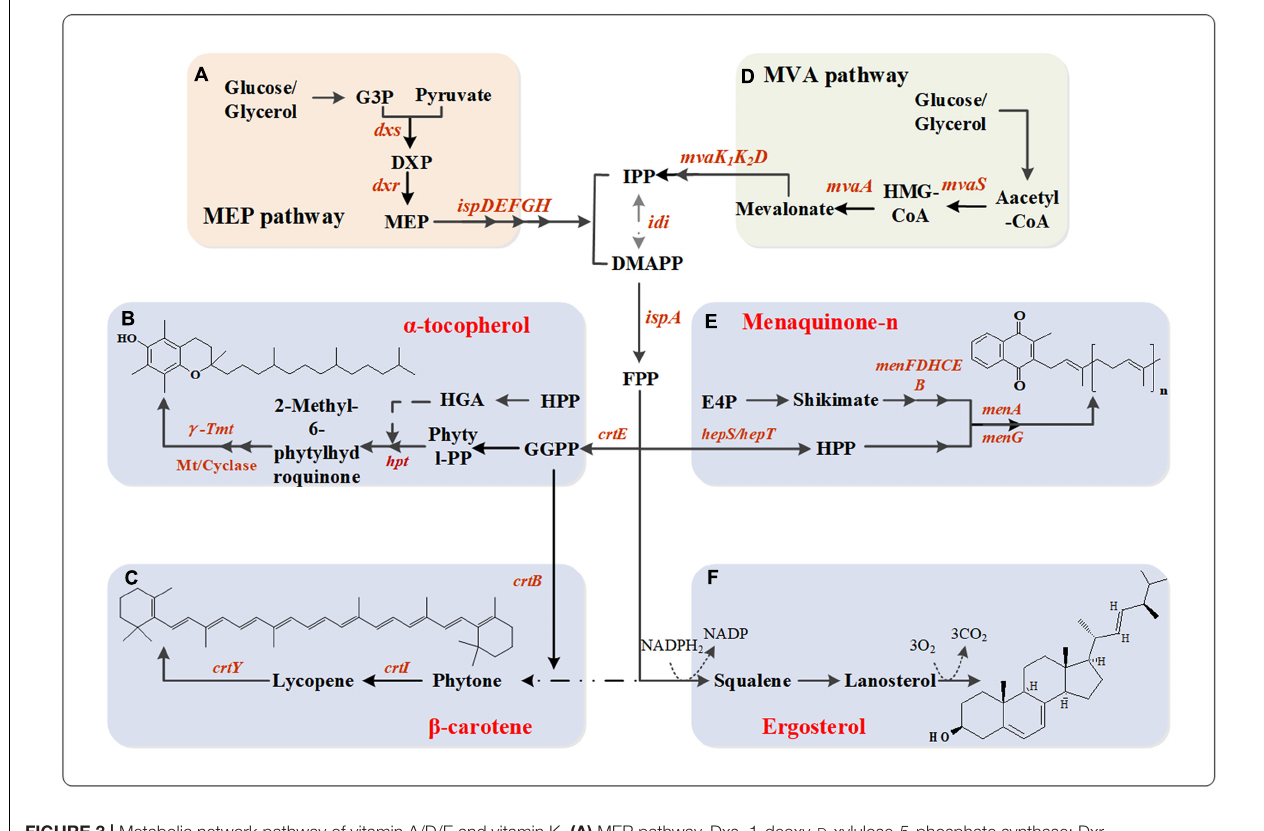
FIGURE 3 | Metabolic network pathway of vitamin A/D/E and vitamin K. (A) MEP pathway. Dxs, 1-deoxy- D -xylulose-5-phosphate synthase; Dxr, 1-deoxy- D -xylulose-5-phosphate reductoisomerase; IspD, 2- C -methyl- D -erythritol 4-phosphate cytidylyltransferase; IspE, 4-diphosphocytidyl-2- C -methyl- D -erythritol kinase; IspF, 2- C -methyl- D -erythritol 2,4-cyclodiphosphate synthase; IspG, 1-hydroxy-2-methyl-2-( E )-butenyl 4-diphosphate synthase; IspH, 4-hydroxy-3-methylbut-2-enyl diphosphate reductase; (B) α -tocopherol biosynthesis pathway. Idi, isopentenyl diphosphate isomerase; IspA, geranyltranstransferase; CrtE, GGPP synthase; hpt, hypoxanthine phosphoribosyltransferase; γ -Tmt, γ -tocopherol methyl-transferase; Mt, methyl-transferase. (C) β -carotene biosynthesis pathway. CrtB, phytoene synthase; CrtI, phytoene desaturase; CrtY, lycopene cyclase. (D) MVA pathway. MvaS, HMG-CoA synthase; MvaA, HMG-CoA reductase; MvaK1, mevalonate kinase; MvaK2, phosphomevalonate kinase; MvaD, diphosphomevalonate decarboxylase; (E) Menaquinone- n biosynthesis pathway. HepS/HepT, heptaprenyl diphosphate synthase component I/II; MenF, isochorismate synthase; MenD, 2-succinyl-5-enolpyruvyl-6-hydroxy-3-cyclohexene-1-carboxylate synthase; MenH, demethylmenaquinone methyltransferase; MenC, o -succinylbenzoate synthase; MenE, o -succinylbenzoate-CoA ligase; MenB, 1,4-dihydroxy-2-naphthoyl-CoA synthase; MenA, 1,4-dihydroxy-2-naphthoate heptaprenyltransferase; MenG, demethylmenaquinone methyltransferase. (F) Ergosterol biosynthesis